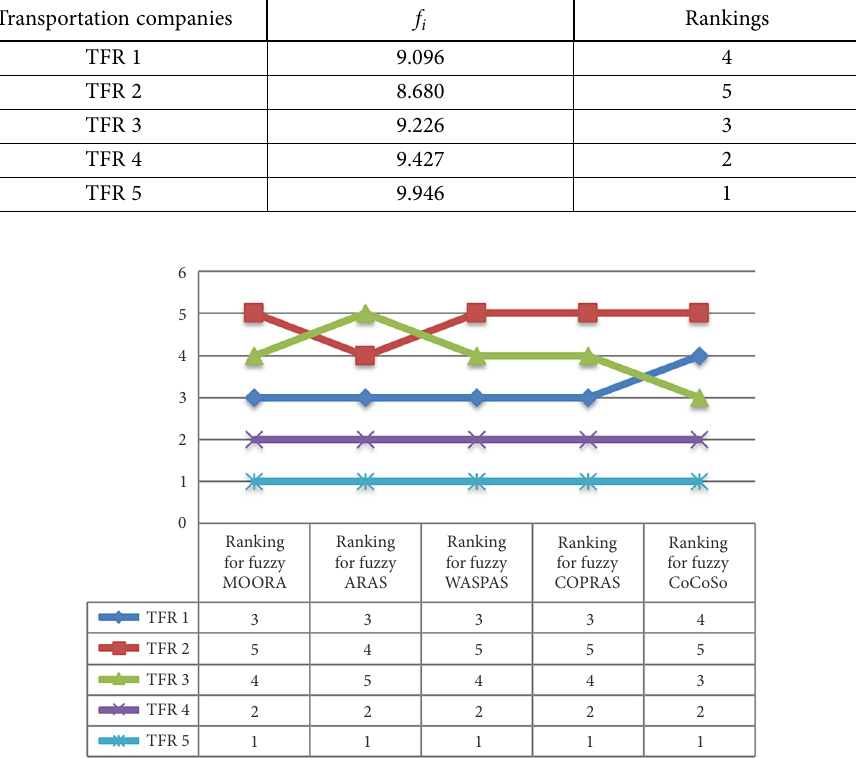
Table 16. The final scores and the rankings of the transportation companies Transportation companies f i Rankings